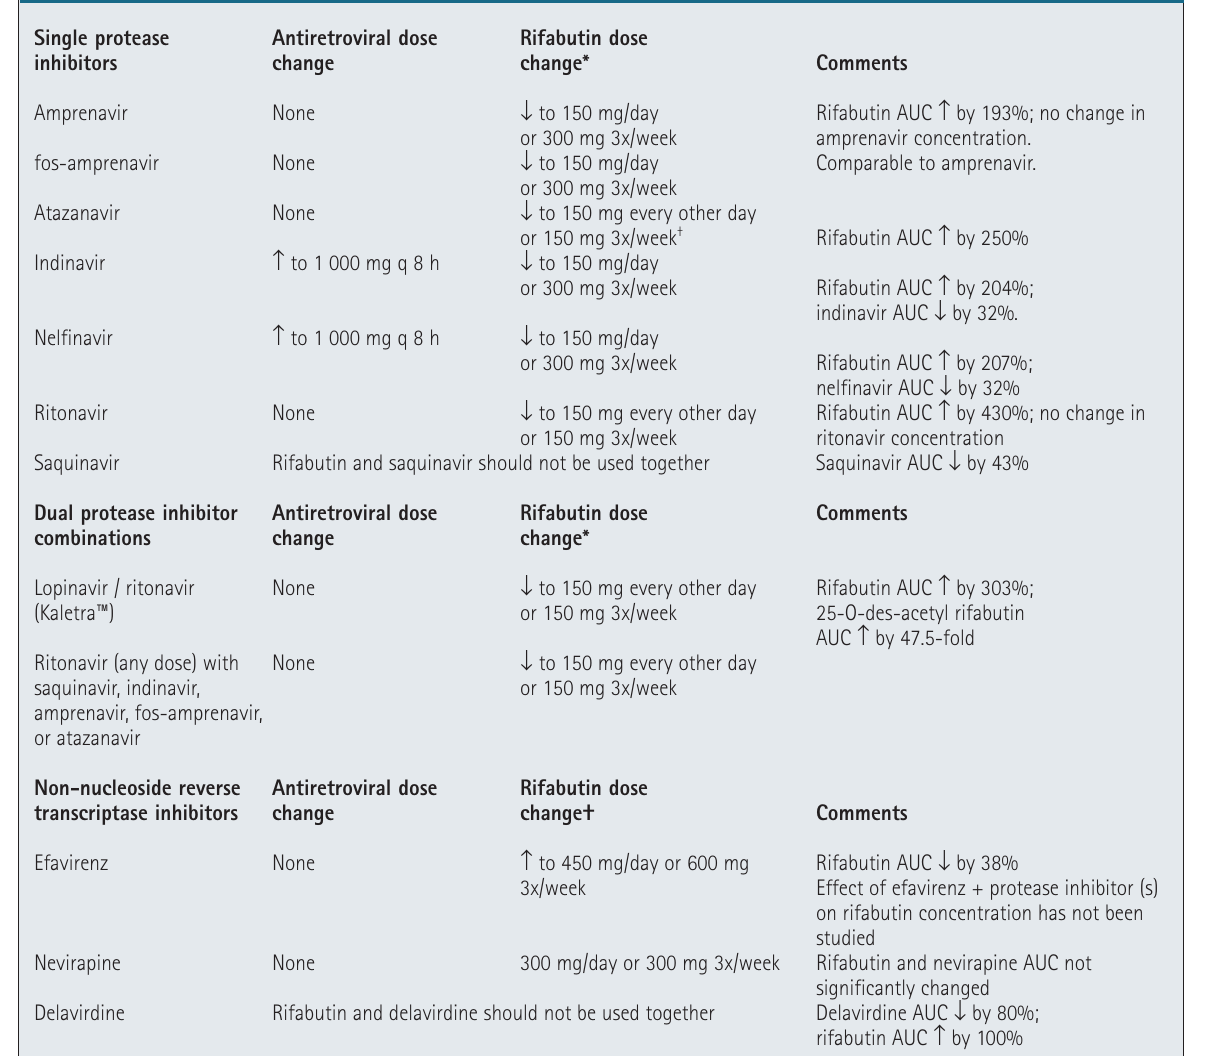
TABLE II. RECOMMENDATIONS FOR CO-ADMINISTERING PROTEASE INHIBITORS AND NON-NUCLEOSIDE REVERSE TRANSCRIPTASE INHIBITORS WITH RIFABUTIN — UNITED STATES,